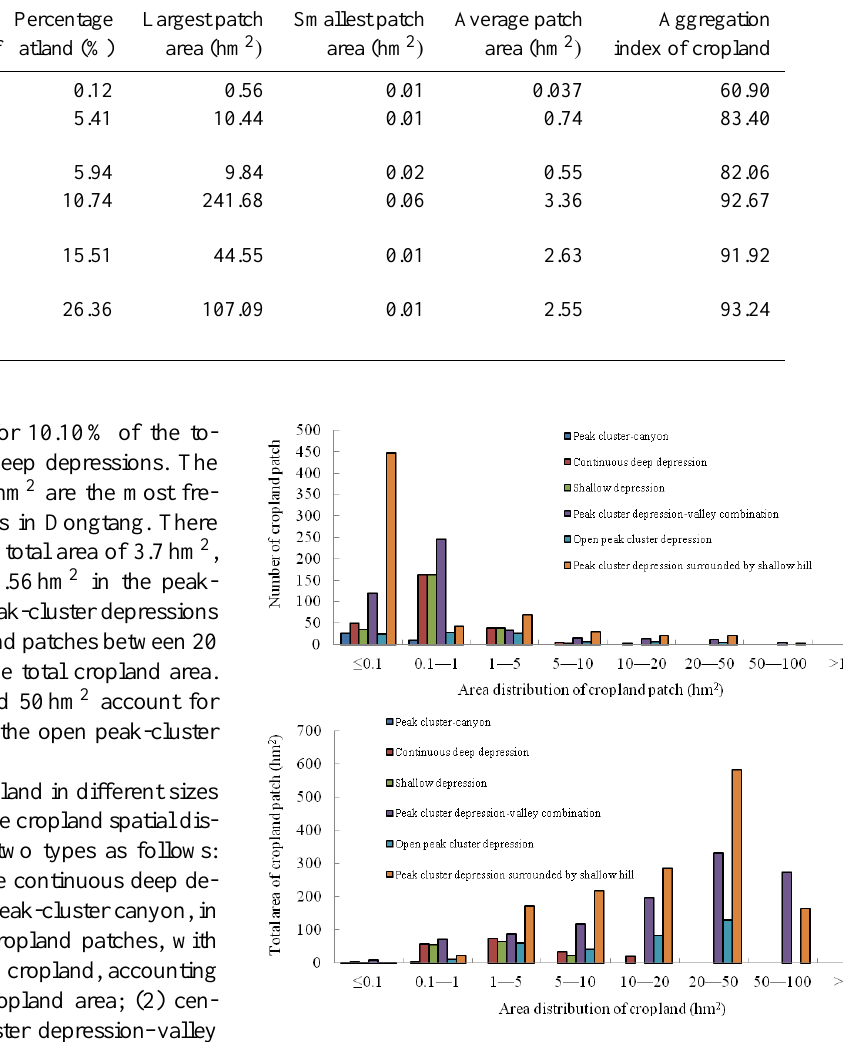
Figure 3. The distribution characteristics of cropland